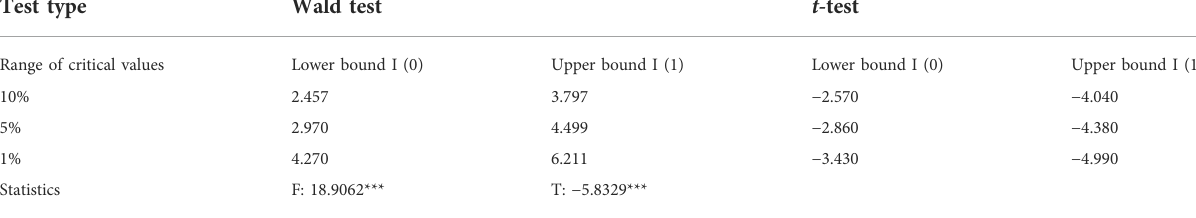
TABLE 3 Boundary cointegration test results.